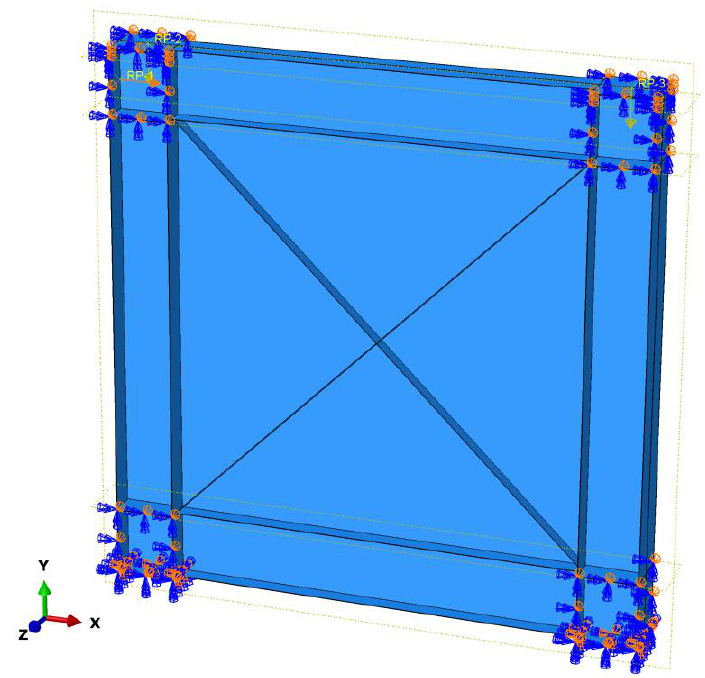
Figure 3. Constitutive behavior of steel.